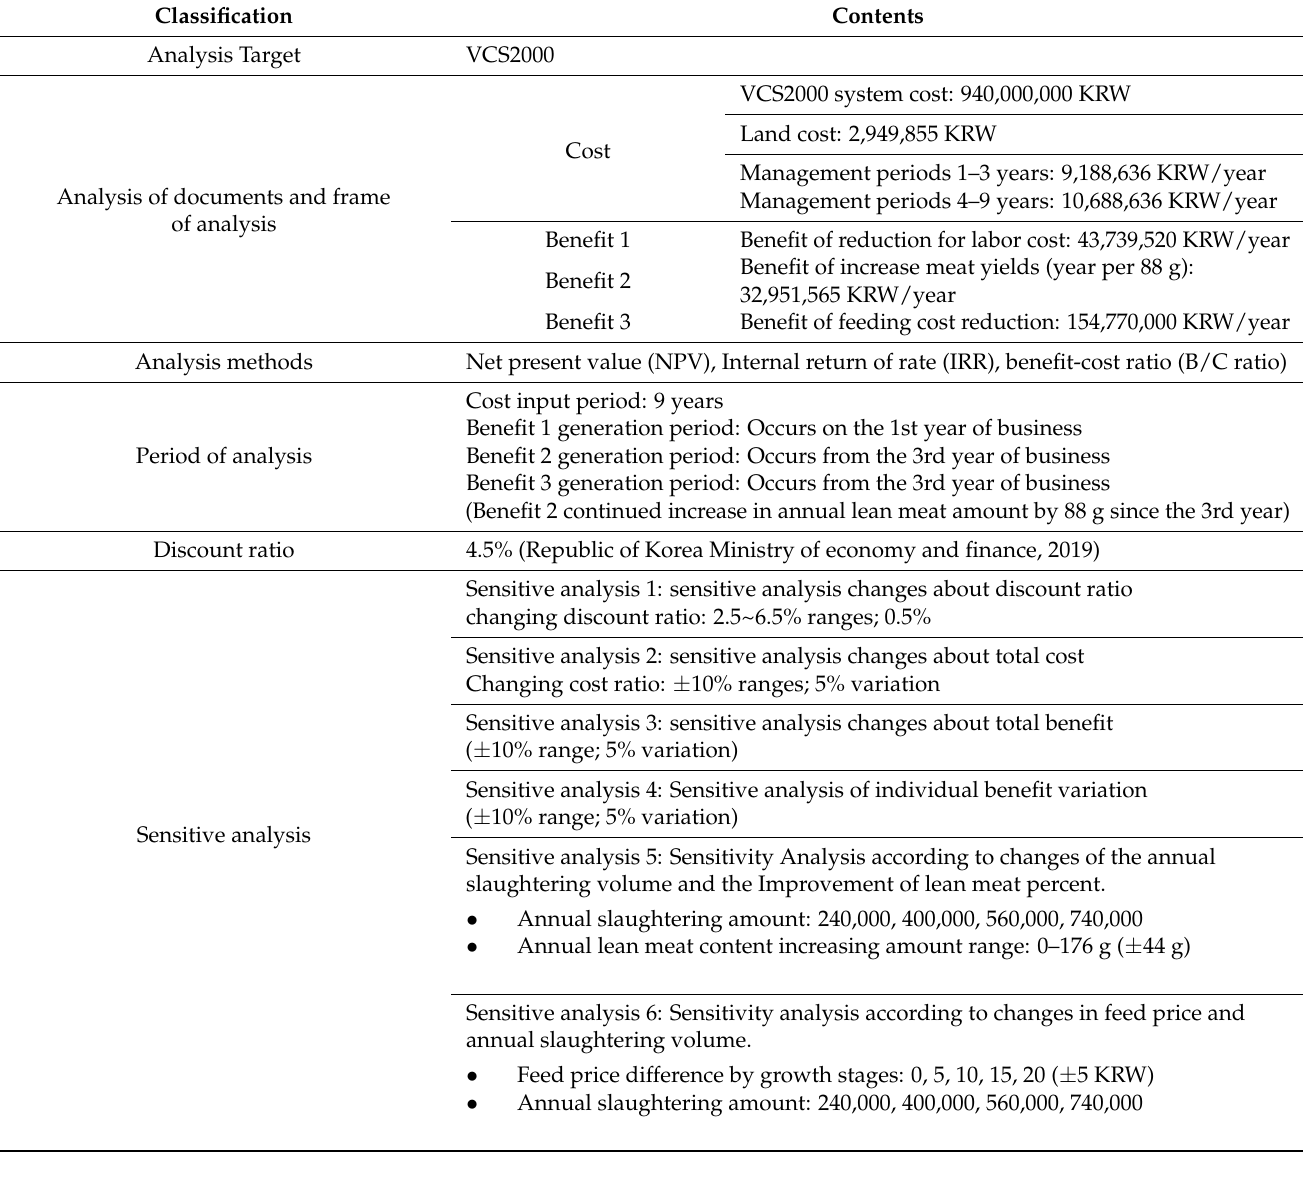
Table 1. VCS2000 resources and scopes of cost-benefit